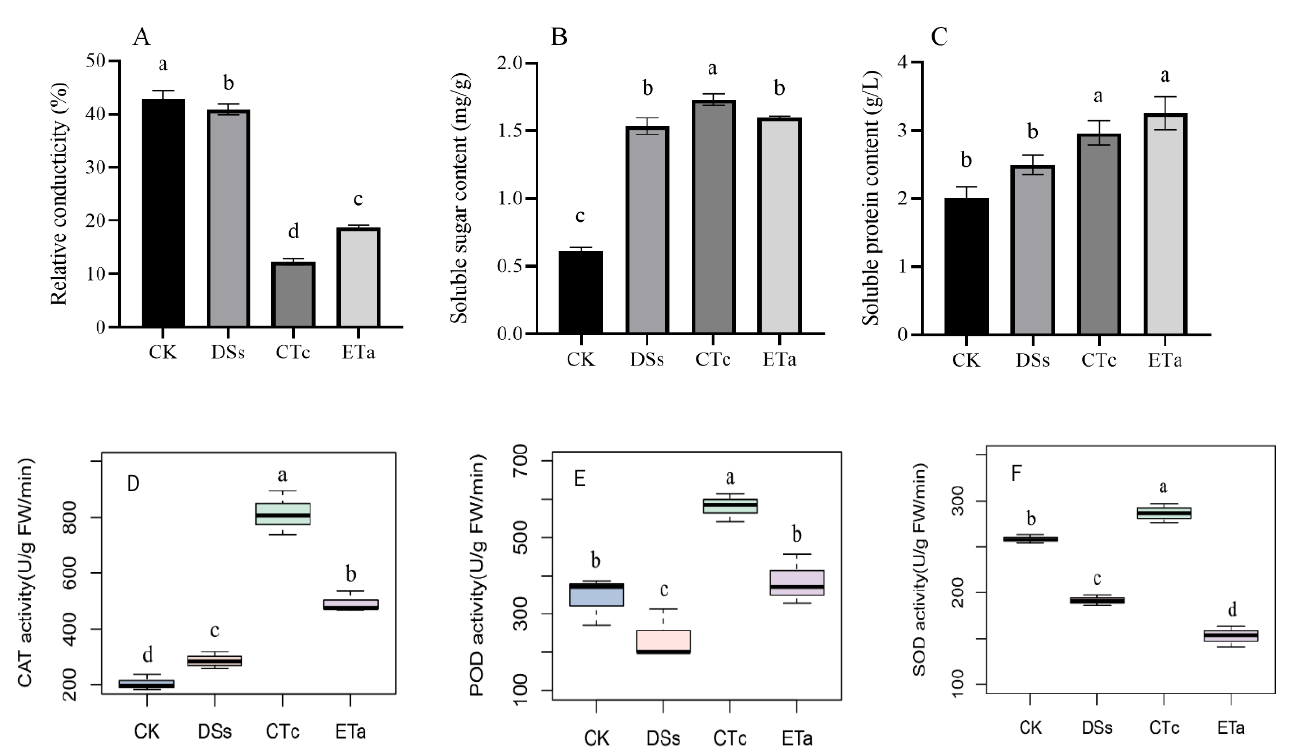
Figure 2. Related resistance indexes of D. officinale in CK, DSs, CTc and ETa groups. ( A ) Relative conductivity, ( B ) soluble sugar content, ( C ) soluble protein content, ( D – F ) CAT, POD and SOD enzymes activities, respectively. Different lowercase letters are significantly different ( p < 0.05) based on Tukey tests.